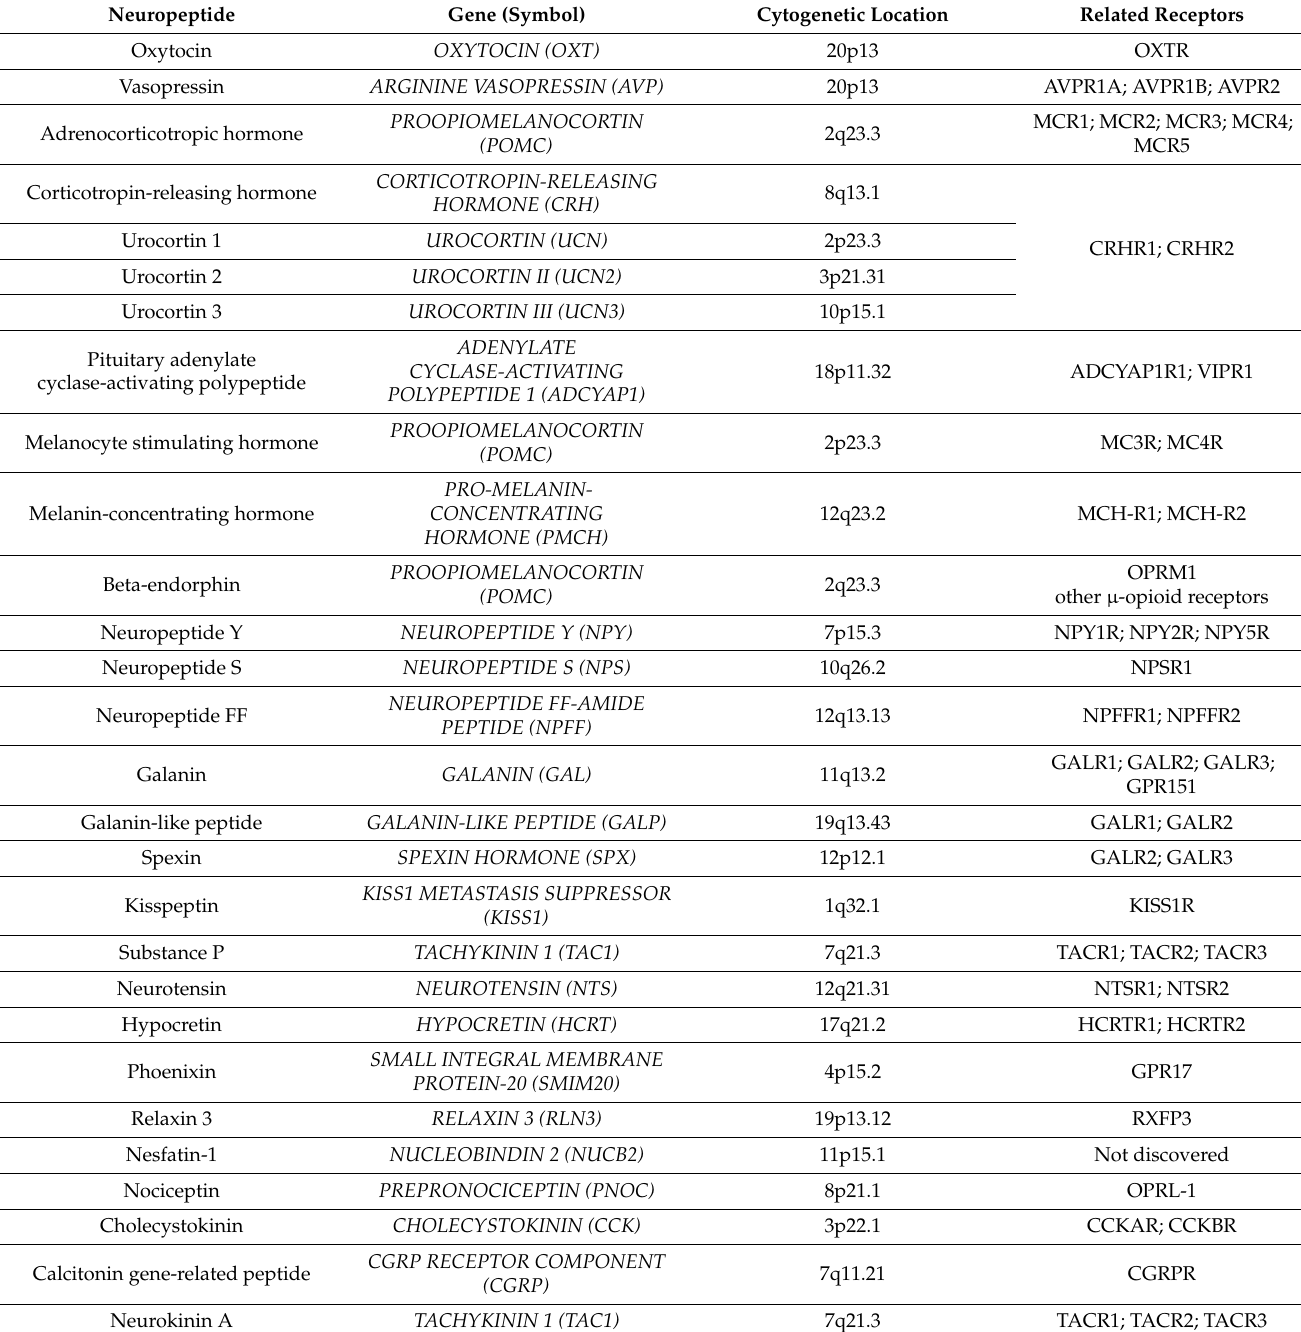
Table 1. Anxiety and depression-related neuropeptides, encoding genes, and related receptors. (Receptors of neuropeptides without any relation to anxiety or depression are not mentioned in this